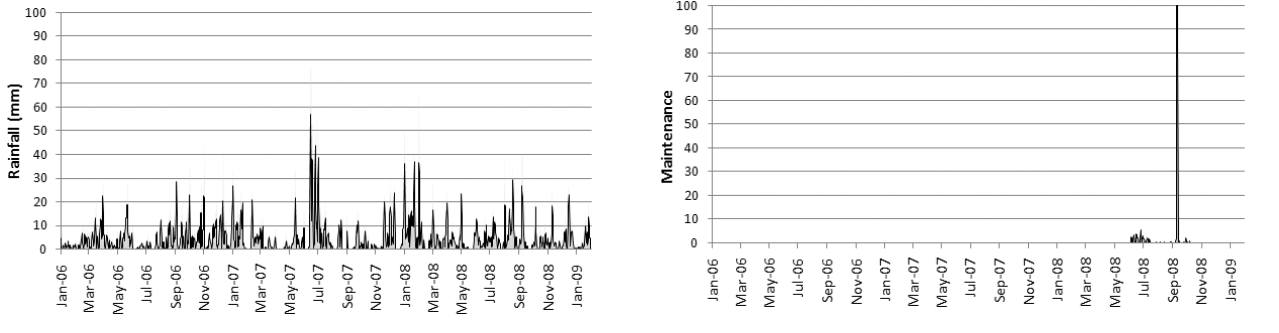
Figure 3. Rainfall vs. date.